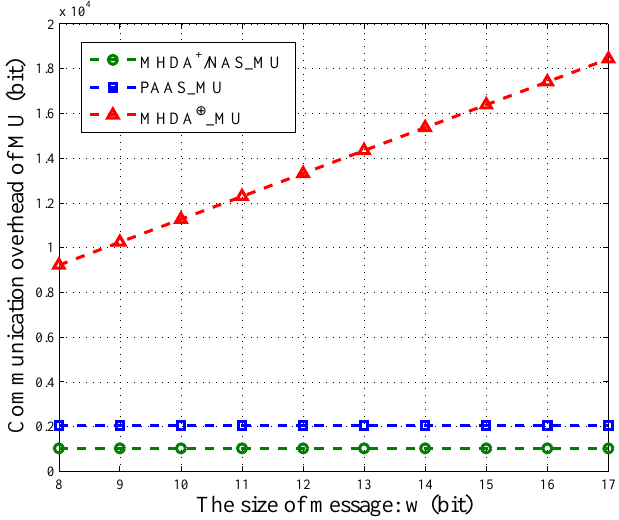
Figure 5. The communication overhead of MU in MHDA + [6], MHDA ⊕ [6], PAAS and NAS.